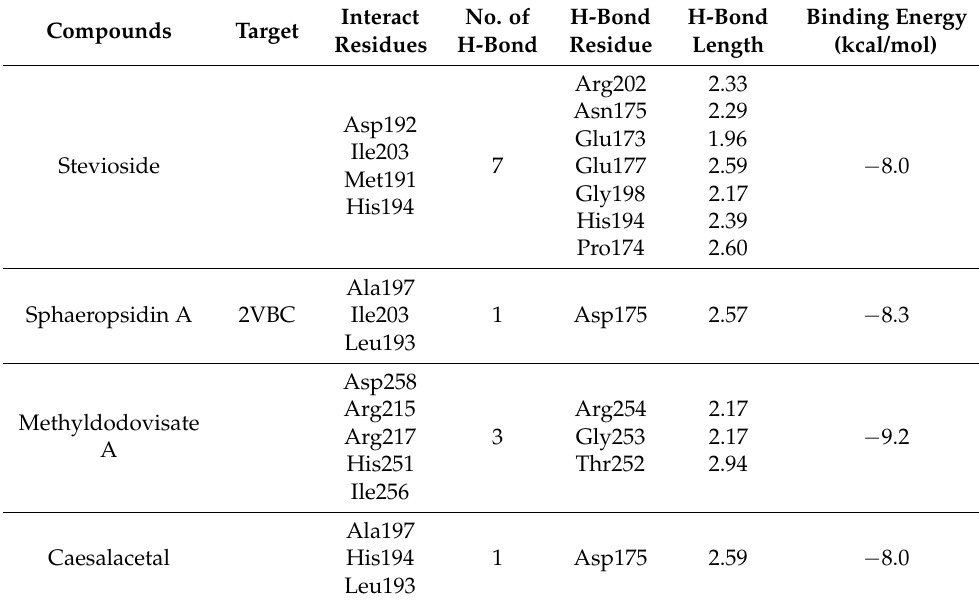
Table 3. The four best results for the docking of natural bioactive ligands with viral proteins target.